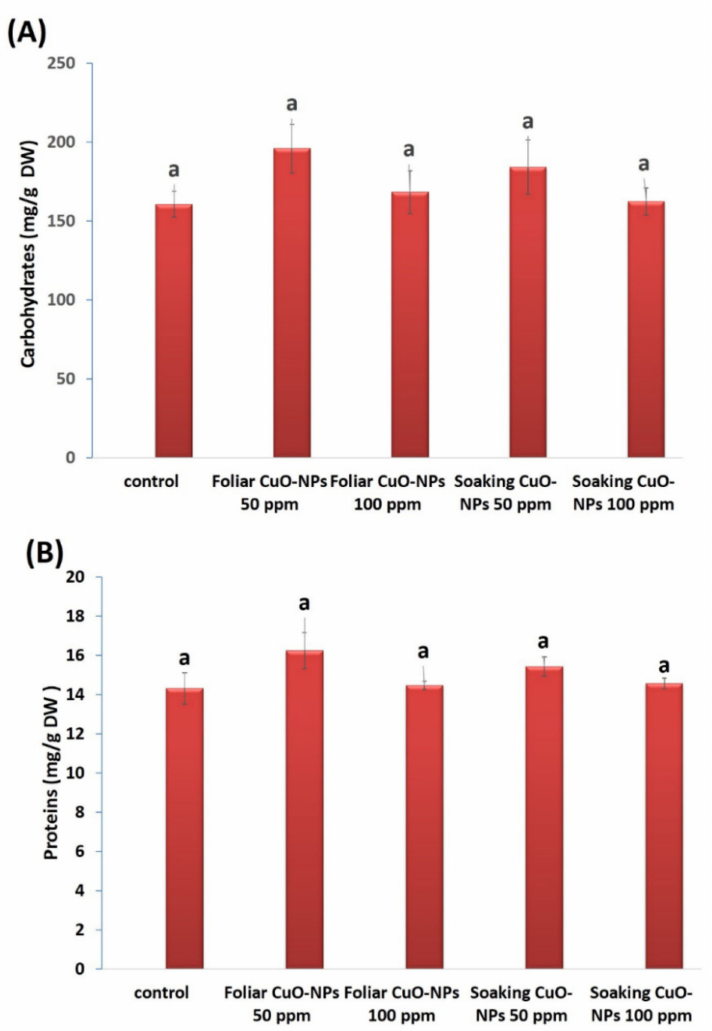
Figure 6. The efficacy of CuO-NPs on soluble carbohydrate ( A ) and soluble protein ( B ) contents (mg/g DW) in wheat plants. Data are statistically different at p ≤ 0.05 by Tukey’s test, ( n = 3); different letters on bars indicate that mean values are significantly different at the significant level of ( p ≤ 0.05), error bars are means ± standard error